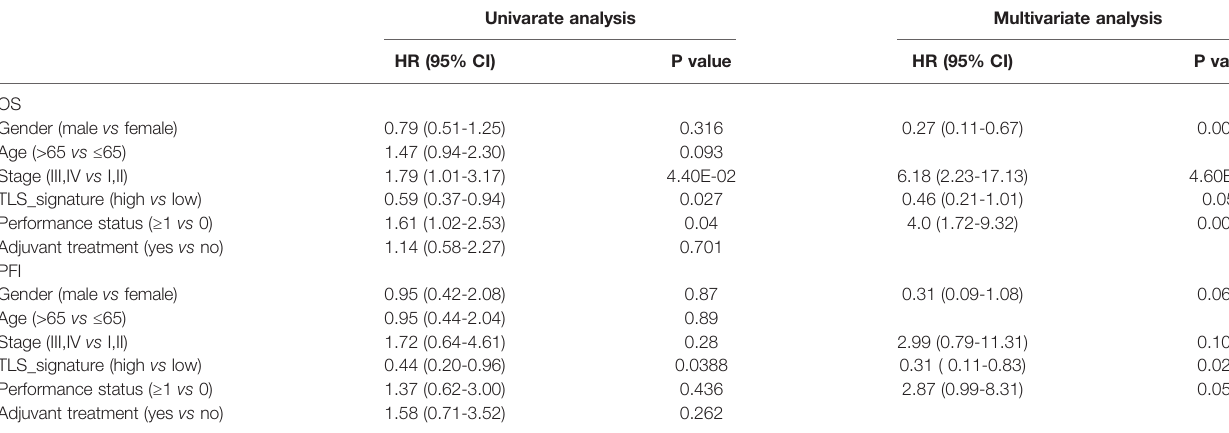
TABLE 2 | Univariate and multivariate cox analyses of prognosis of LUAD patients in the GSE37745 dataset. Univarate analysis Multivariate